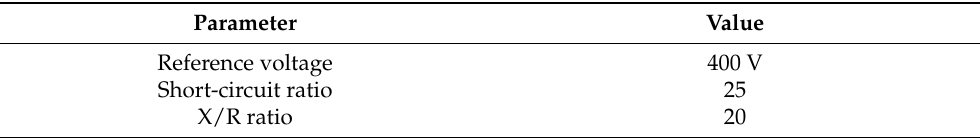
Table 1. Grid model parameters.